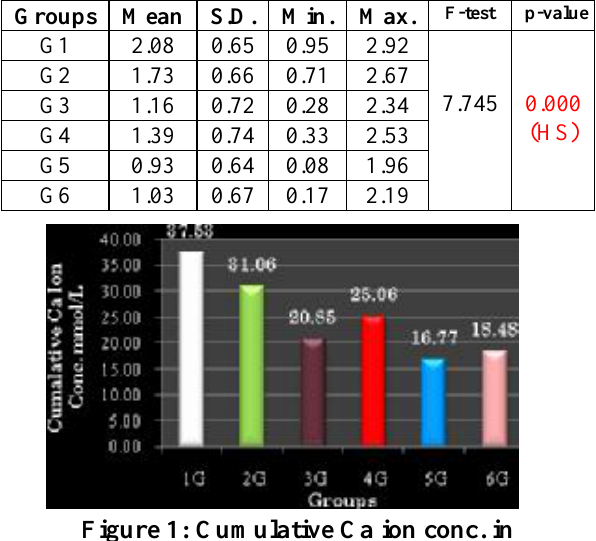
Figure 1: Cumulative Ca ion conc. in mmol/L over 18 days of acidic challenge revealed that unsealed specimens (G1) released the highest amount of Ca ion while, the other specimens released the less specially the combined ones (G5 and